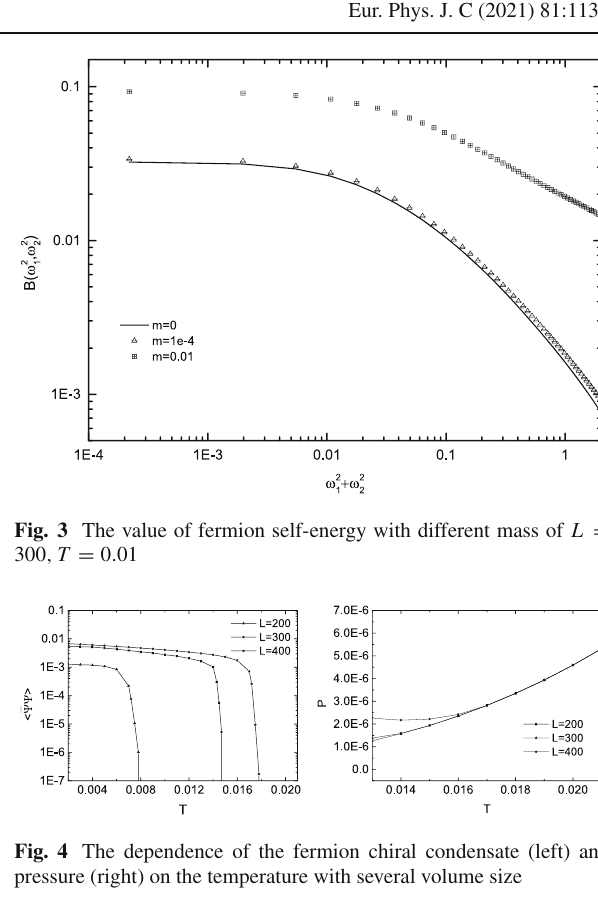
Fig. 2 The behaviors of fermion self-energy with different summation upper bounds and range of volume and temperature(with L = 300) at T = 0 . 01 , m = 0 . 01